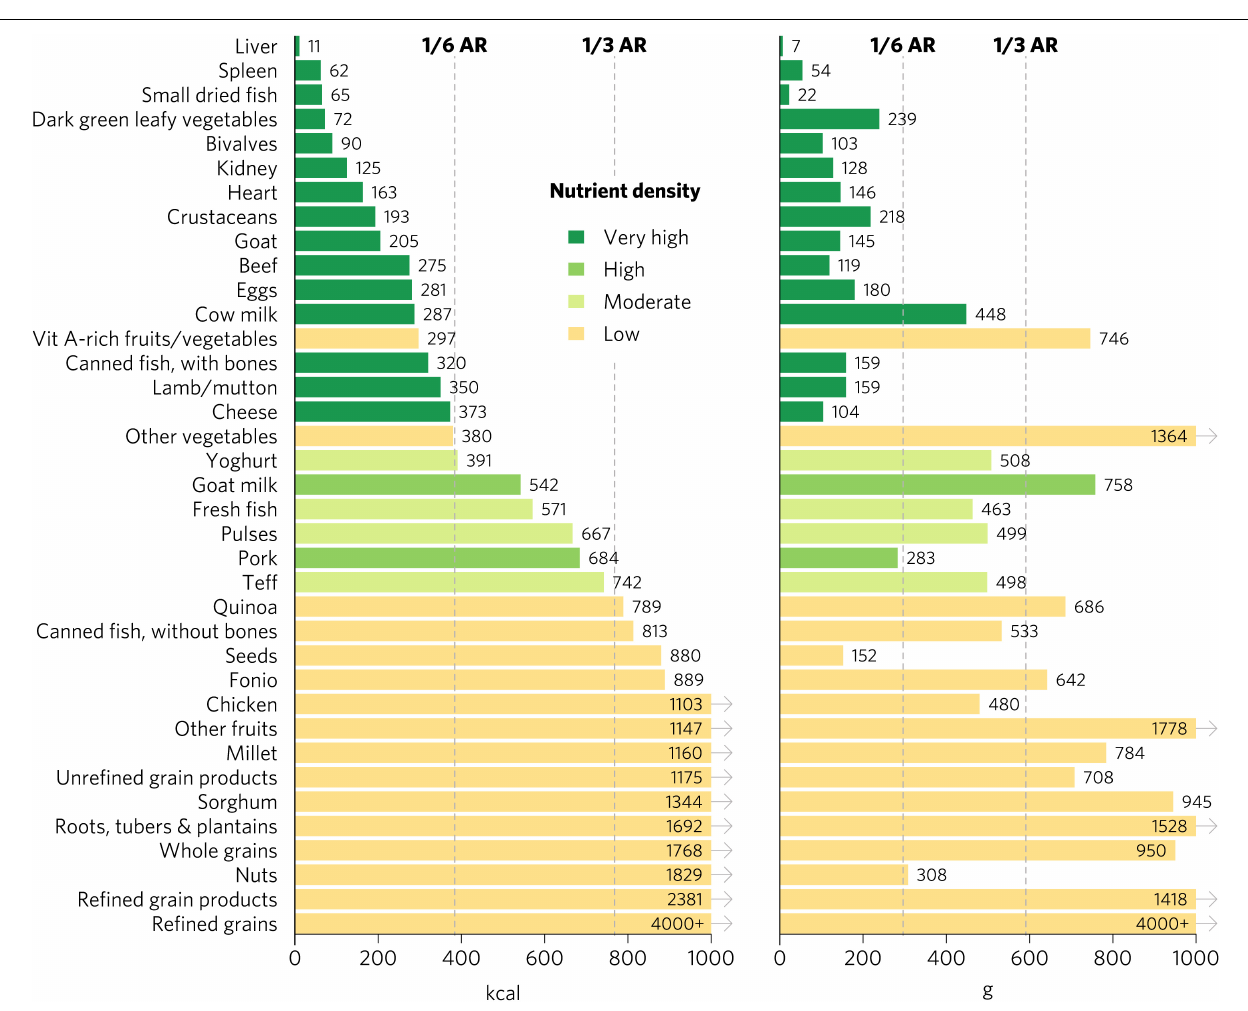
FIGURE 1 | Calories and grams needed to provide an average of one-third of recommended intakes of vitamin A, folate, vitamin B 12 , calcium, iron, and zinc for women of reproductive age. Each micronutrient’s contribution is capped at 100% of recommended intakes. Hypothetical average requirements for mass are based on an energy density of 1.3 kcal/g. AR, average requirement; Vit,